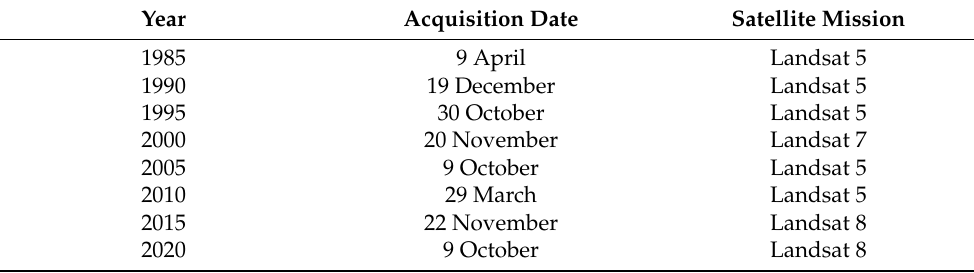
Table 2. Landsat image selection dates for the shoreline